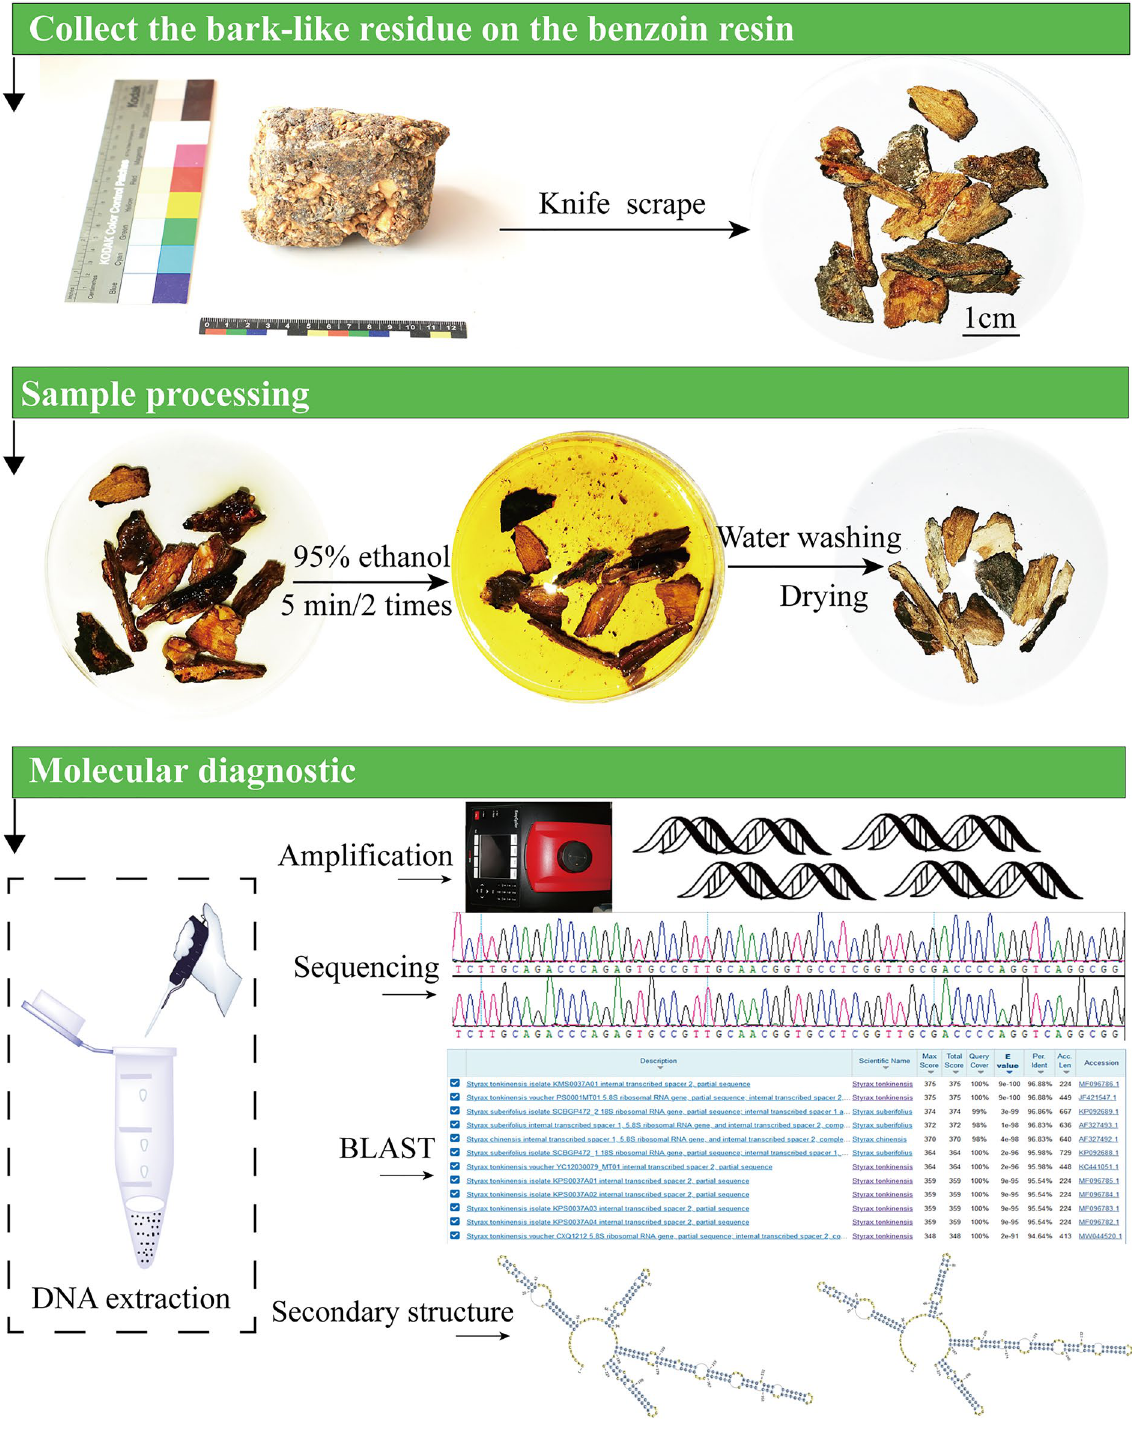
Figure 1. Process of pretreatment and molecular diagnostic identification of bark-like residues on